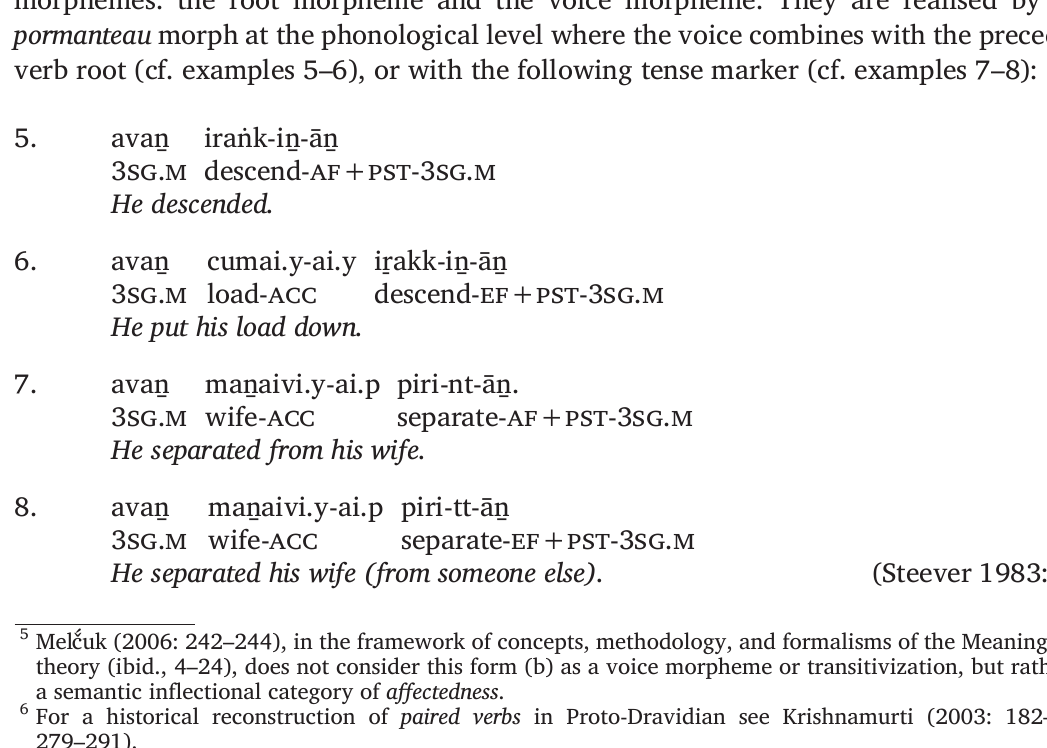
derived verb stem verb root voice Figure 2: Structure of derived verb stem.